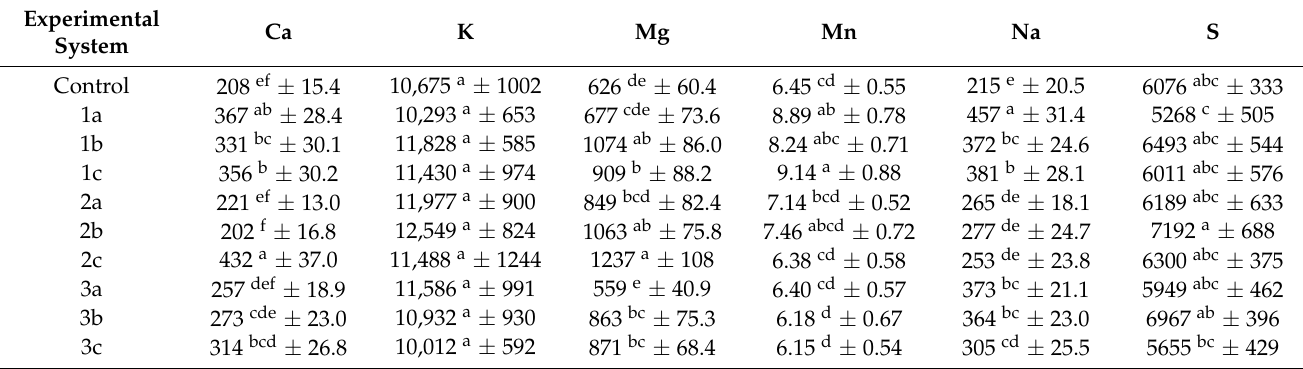
Table 3. Content (mg kg − 1 DW) of selected elements in Pholiota nameko fruit bodies.